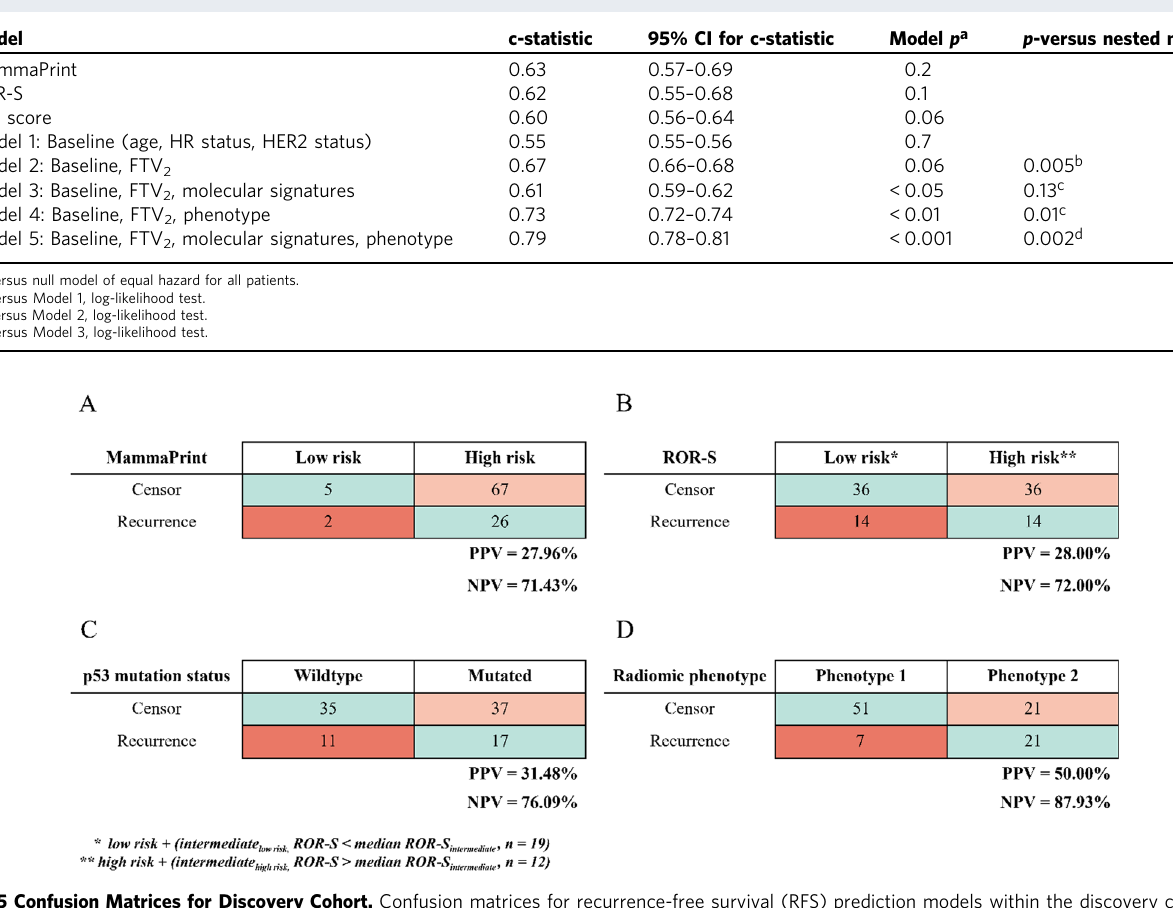
Fig. 5 Confusion Matrices for Discovery Cohort. Confusion matrices for recurrence-free survival (RFS) prediction models within the discovery cohort using MammaPrint score ( A ), ROR-S ( B ), p53 mutation status ( C ), and radiomic phenotype ( D tumors decreased in morphologic fl atness from T1 to T2 (Supple- mentary Table 6). Signi fi cant separation of women by radiomic phenotype assignment by Kaplan-Meier curves for women with HER2 + and